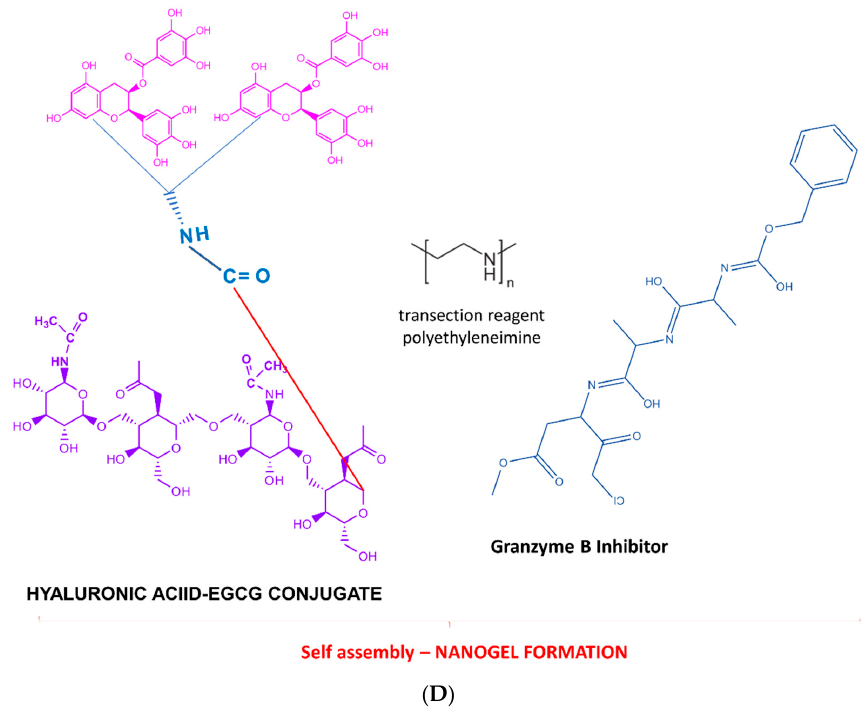
Figure 5. Synthesis mechanism of self-assembled hyaluronic acid-EGCG-polyethyleneimine-Granzyme B nanogel (Adapted from Reference [48]): ( A ) formation of EGCG dimer by an aldehyde-mediated reaction between the aldehyde N-(fluorenylmethoxycarbonyl)-L-alaninal and A-ring of EGCG molecules, ( B ) de-protection of EGCG dimer in the presence of dimethylformamide and trimethylamine, ( C ) conjugation of EGCG de-protected dimer to hyaluronic acid by a carbodiimide reaction, ( D ) nanogel formation by self-assembly between hyaluronic acid–EGCG conjugate, the transection reagent polyethyleneimine and Granzyme B